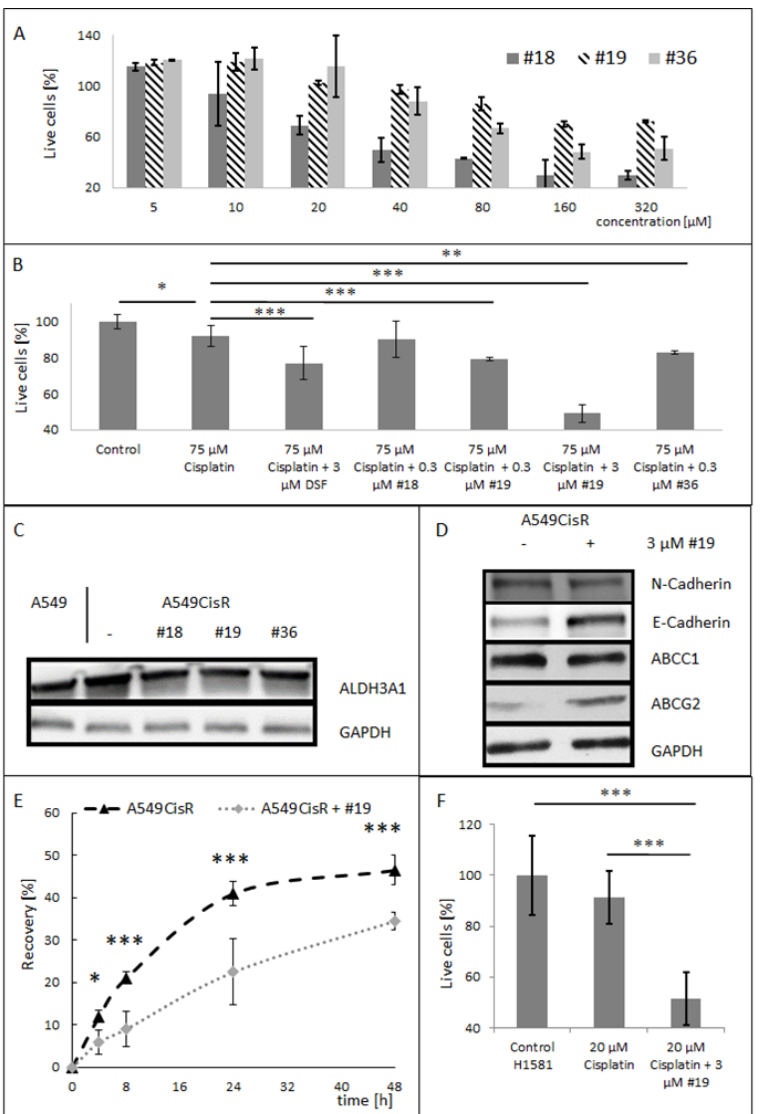
Figure 4. Induction of cisplatin-resistance reversion by isothiocyanates. ( A ) The impact of isothio- cyanate concentration on A549 cell viability — WST-1 assay after 24 h supplementation with com- pounds 18 , 19 , or 36 (ScienCell, Research Lab., Carlsbad, CA, USA). ( B ) Reversion of cisplatin resistance (WST-1 assay). ( C ) Downregulation of ALDH3A1 by ITCs. Long-term (3 µ M, 15 days) impact of compound 19 on EMT marker and ABC protein levels. ( D ) Standard SDS-PAGE Western blot. ( E ) Wound-healing-like analysis of the impact of compound 19 on cisplatin-resistant NSCLC cell migration. A549CisR and A549CisR supplemented with compound 19 (3 µ M, 15 days) cells were seeded on a six-well plate, grown to confluence. A wound was made and rinsed twice with PBS. New full medium was added. The wounded area was visualized after 0, 4, 8, 24, and 48 h using an OLYMPUS IX53 microscope and calculated by ImageJ software, n = 3. ( F ) ITC 19 increases cisplatin sensitiza- tion of advanced NSCLC cells NCI-H1581. * p < 0.05; ** p < 0.005; *** p < 0.001, not statistically significant—no